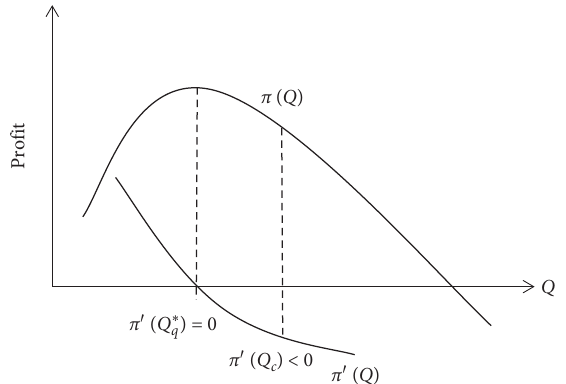
Figure 3: Comparisons of centralized SC and initial order quantity under order quantity commitment